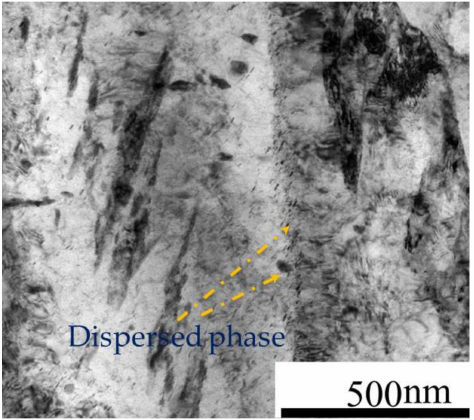
Figure 5. Transmission electron microscopy (TEM) of the fine-grained samples of M50NiL